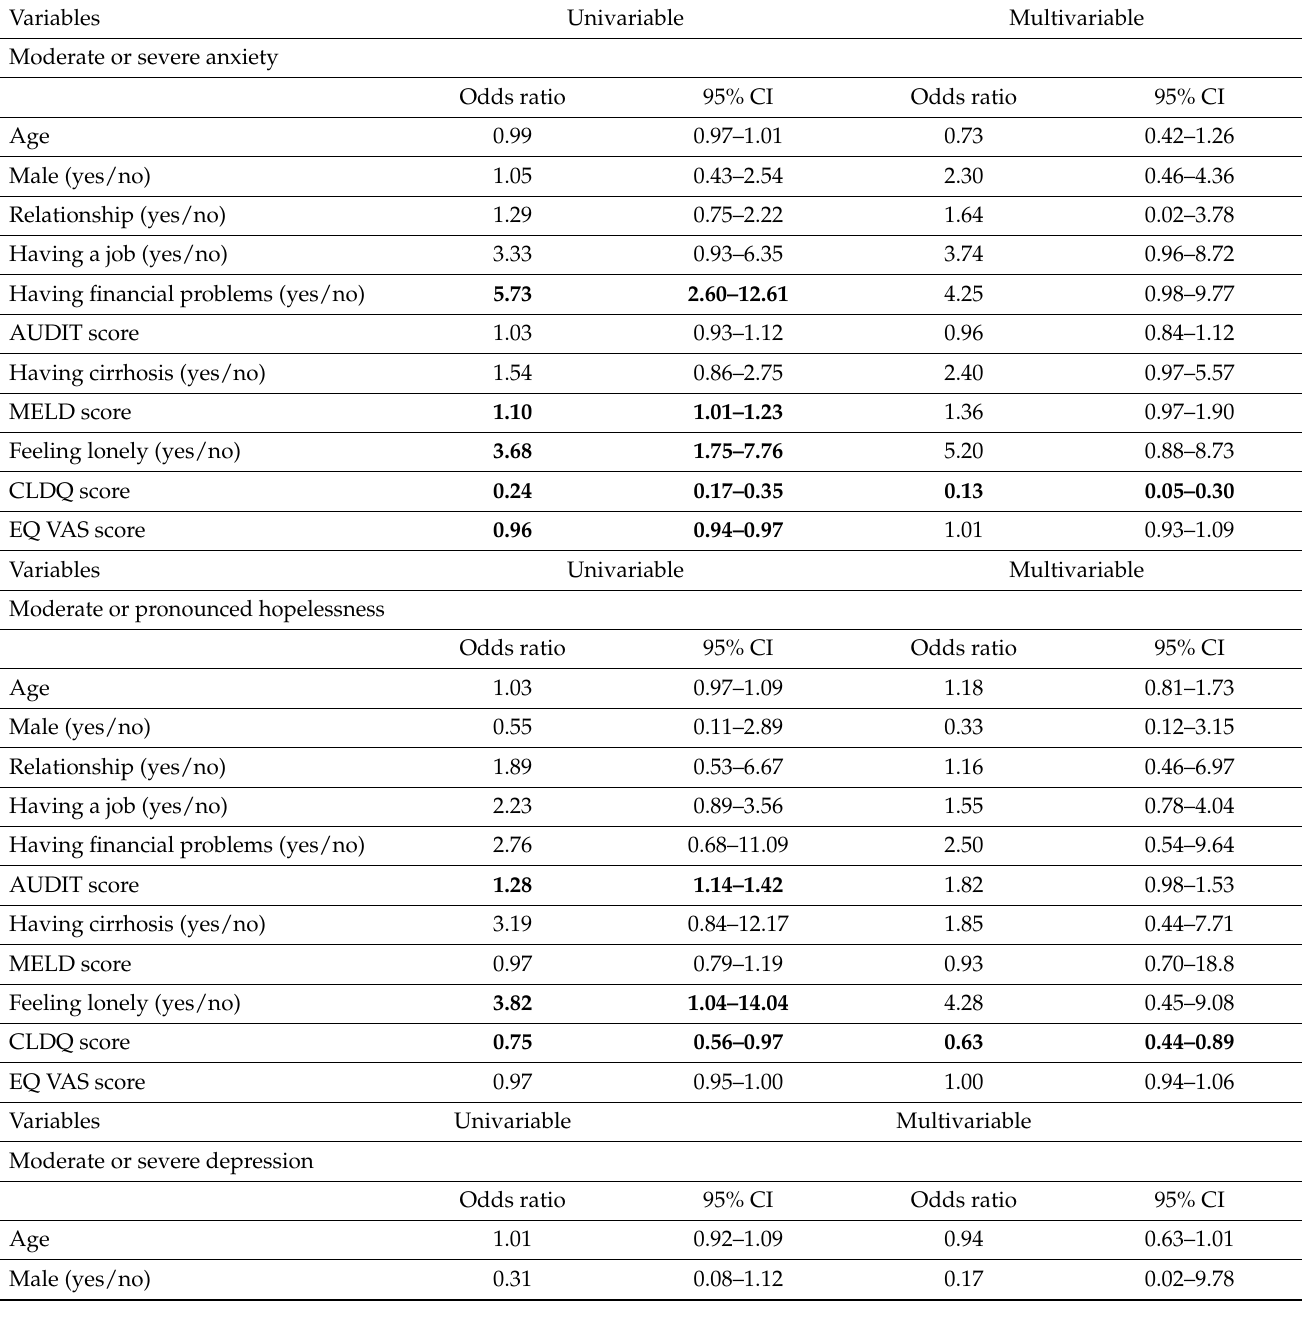
Table 5. Univariable and multivariable logistic regression analyses of the association between the predictor variables and the outcome variables anxiety, hopelessness, and